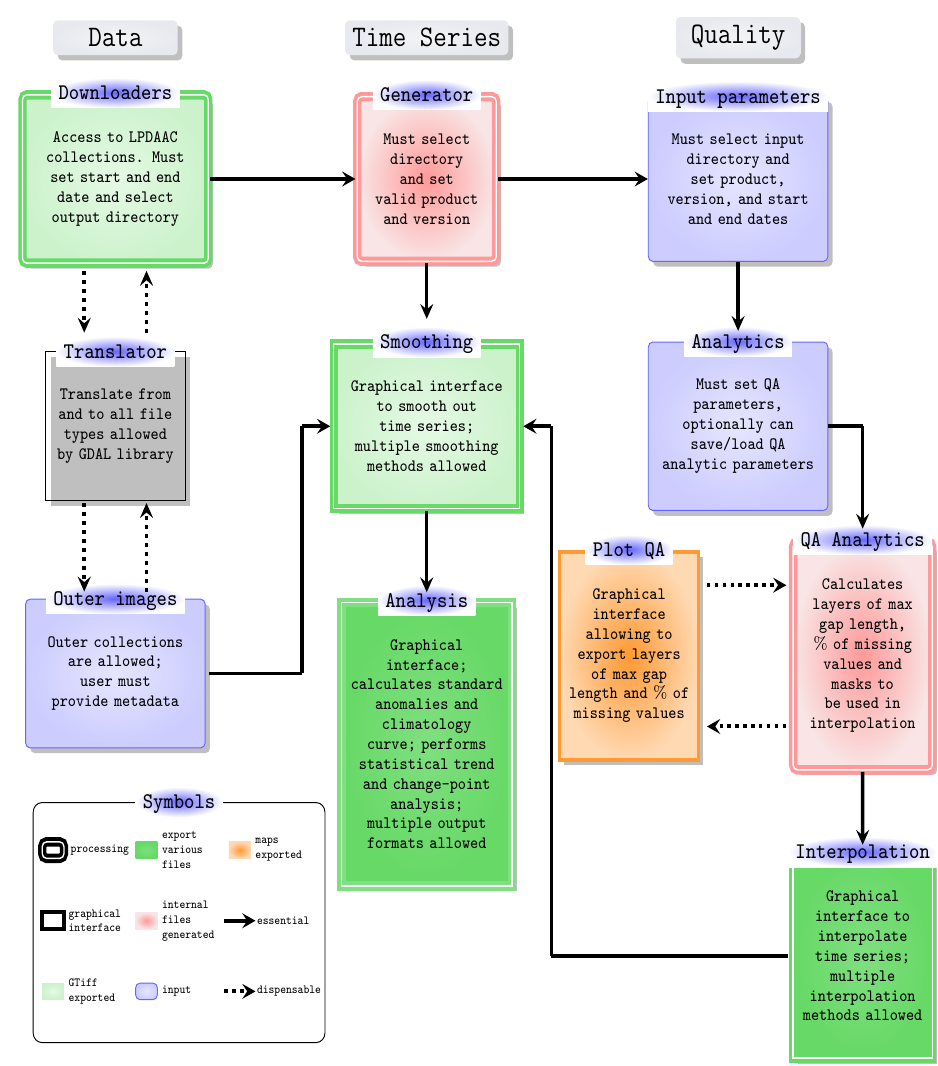
Figure 7. TATSSI graphical user interface (GUI)